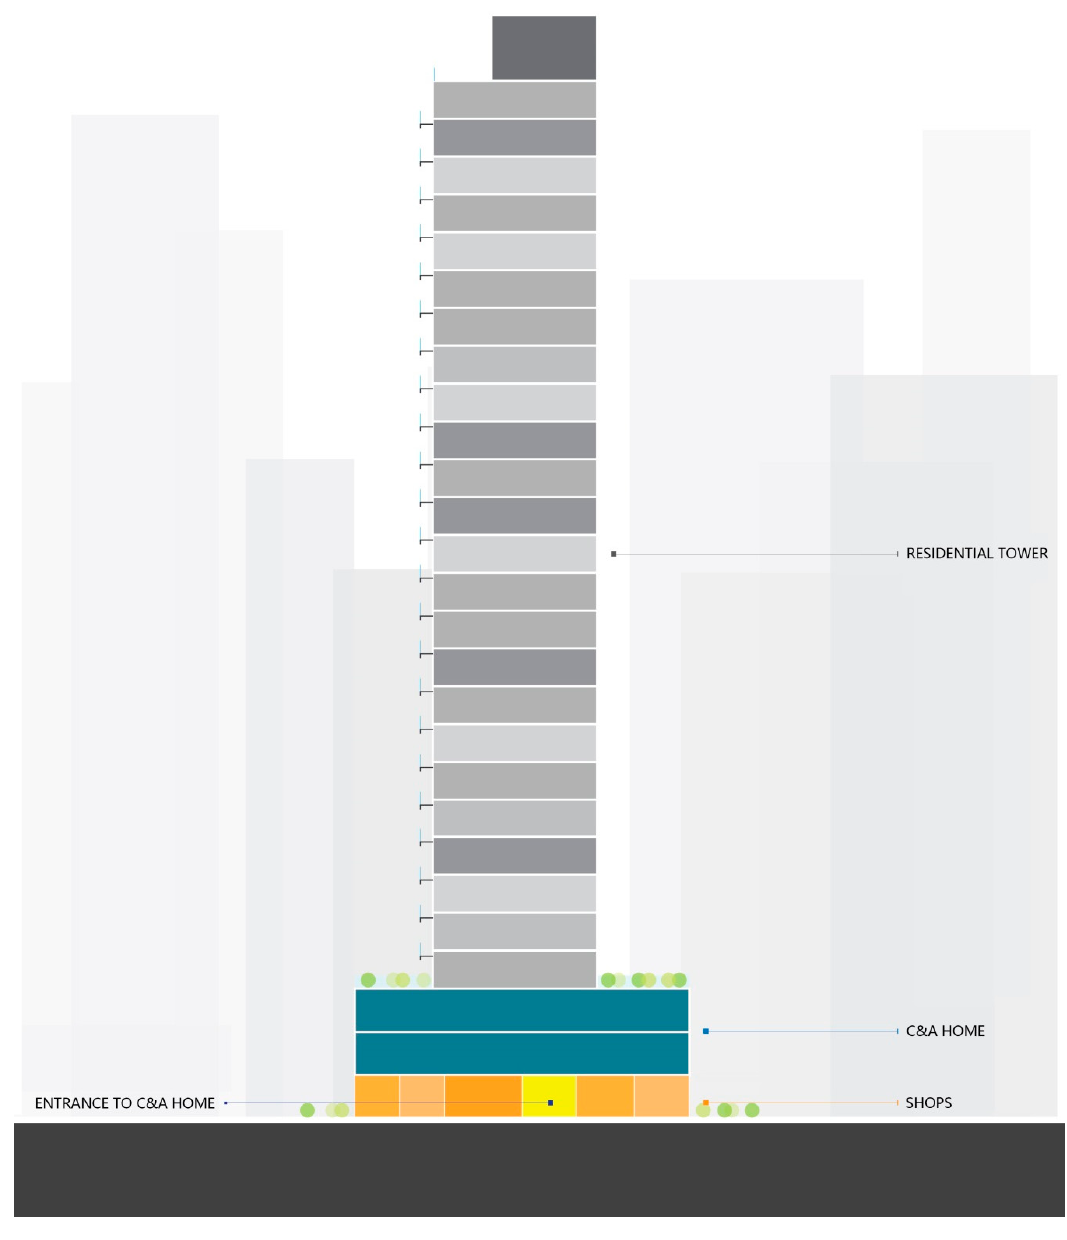
Figure 2. C&A homes in tall buildings (drawn by the authors).